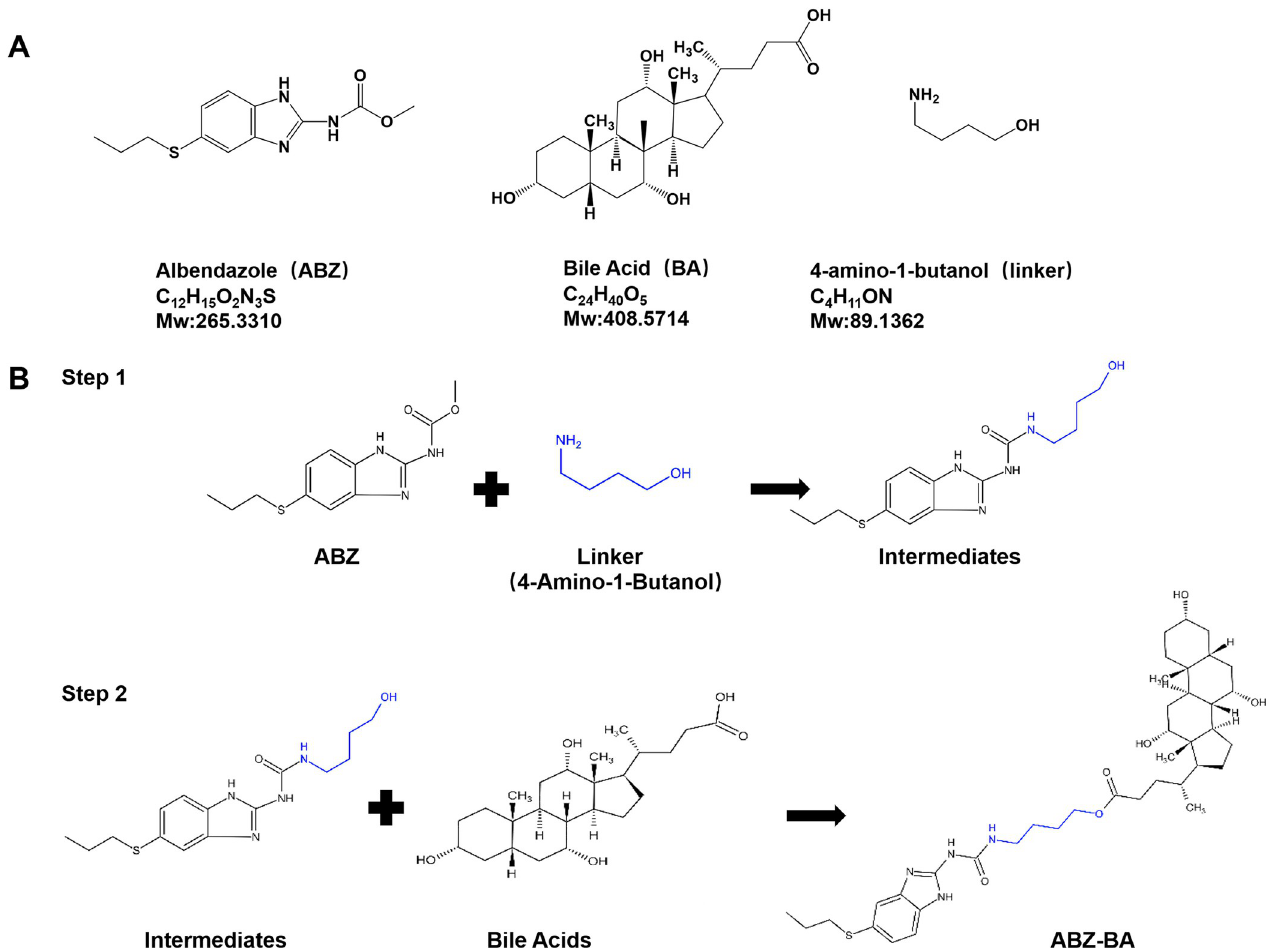
Fig 2. Structure, physicochemical properties, and synthesis route of ABZ-BA. (A) Structure of drug and ABZ-BA albendazole, bile acid and 4-amino- 1-butanol. (B)ABZ-BA was synthesized in two steps with 4-amino-1-butanol as a linker.